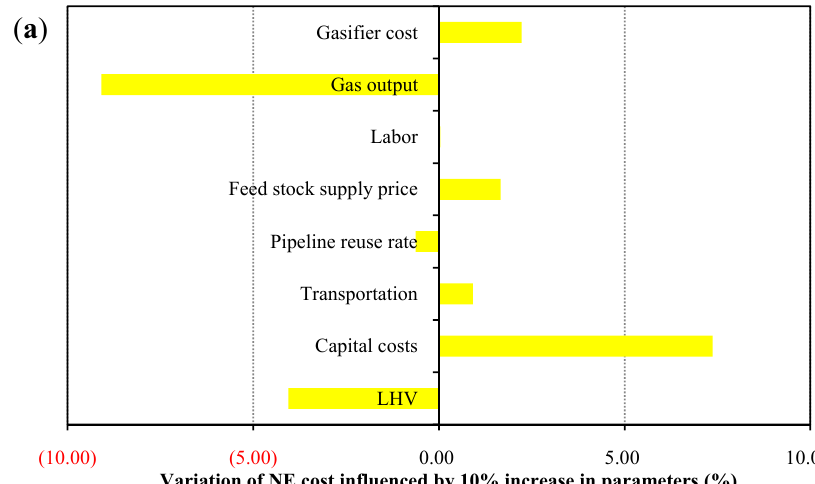
Figure 5. Sensitivity analysis of parameters (variation by 10%) related to NE cost ( a ) and associated GHG emissions ( b